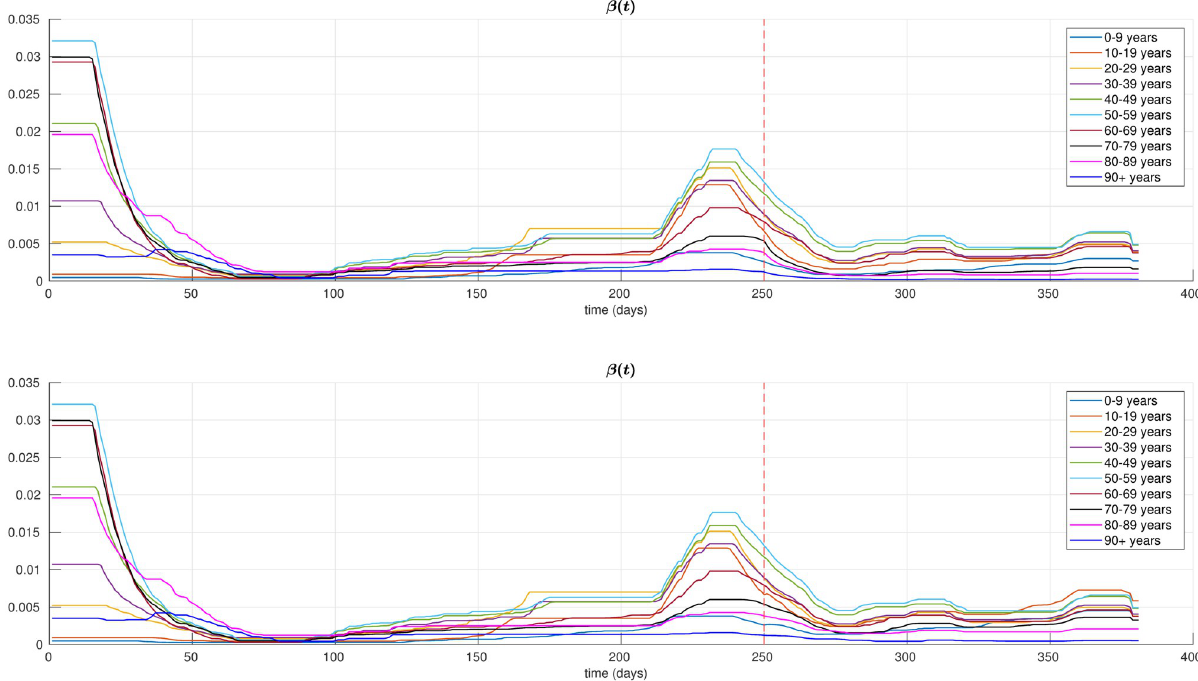
Fig 4. Time-varying contagion rates β ( t ) in the two scenarios considered in the experimental section. A strengthened lockdown for the eldest age i classes (top), a relaxed lockdown for the youngest age classes (bottom). The dashed red line denotes the start day of these scenarios.